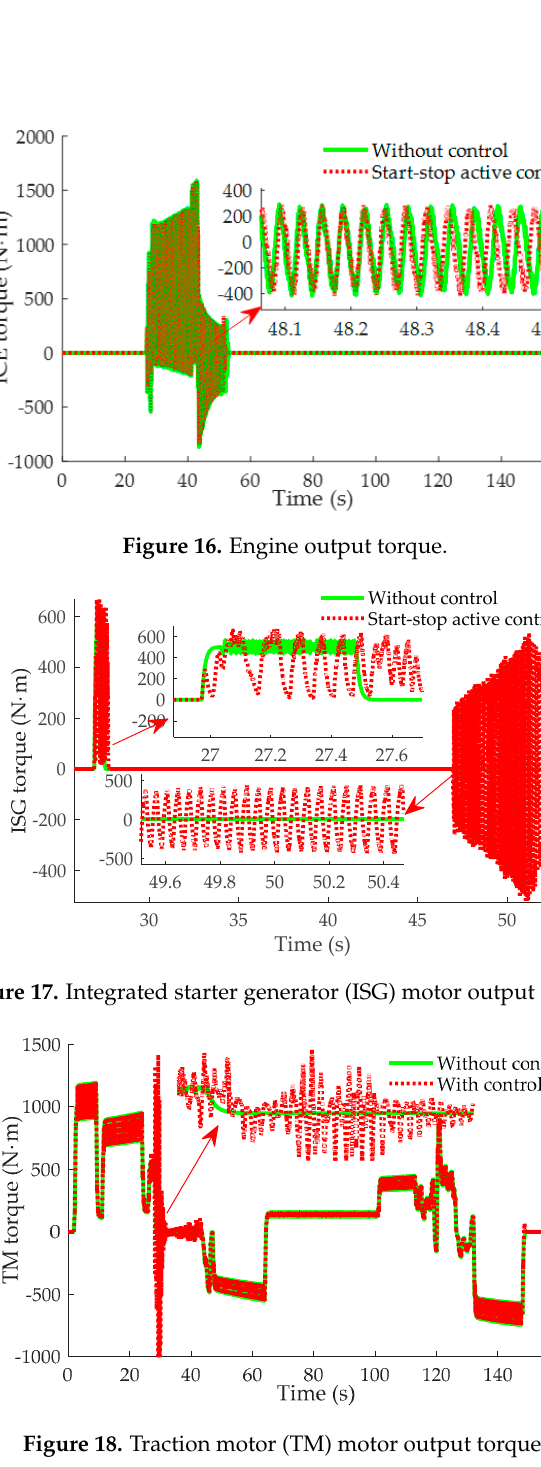
Figure 19. Engine speed.